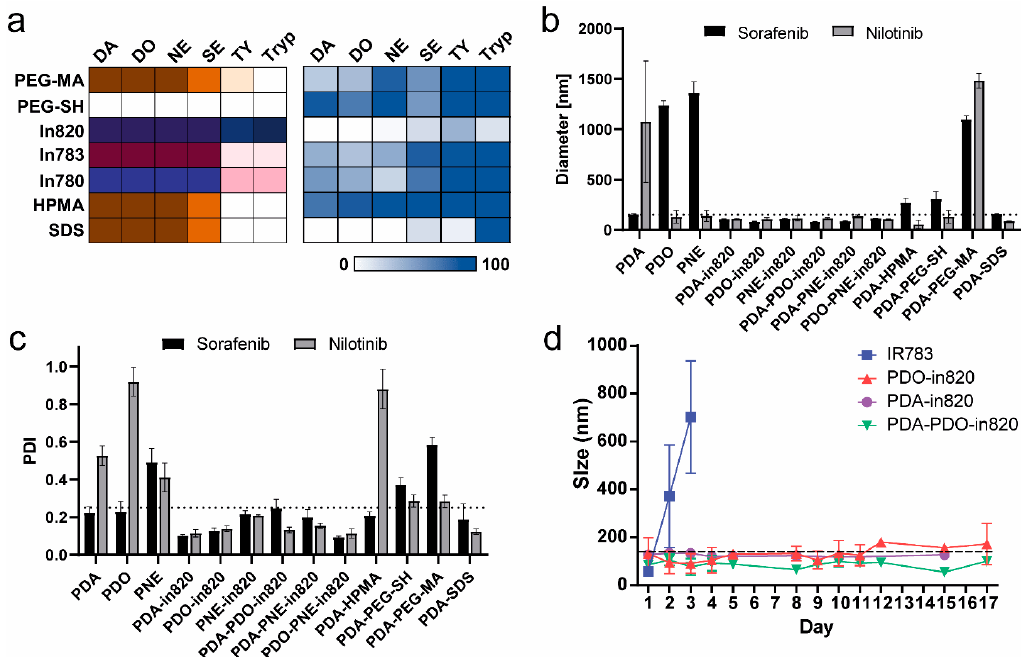
Figure 2. Selection of top copolymer. ( a ) Left comonomers matrix, illustration of colors after a 4 h reaction in sodium bicarbonate buffer 0.1 M. Right-normalized confluence of blue emission at 477 nm with nilotinib. ( b ) Average diameter of sorafenib and nilotinib nanoparticles formulated with different polymers. ( c ) Polydispersity index (PDI) of nanoparticles made with different copolymers. ( d ) Stabilization over time of nilotinib nanoparticles formulated with different stabilizers.